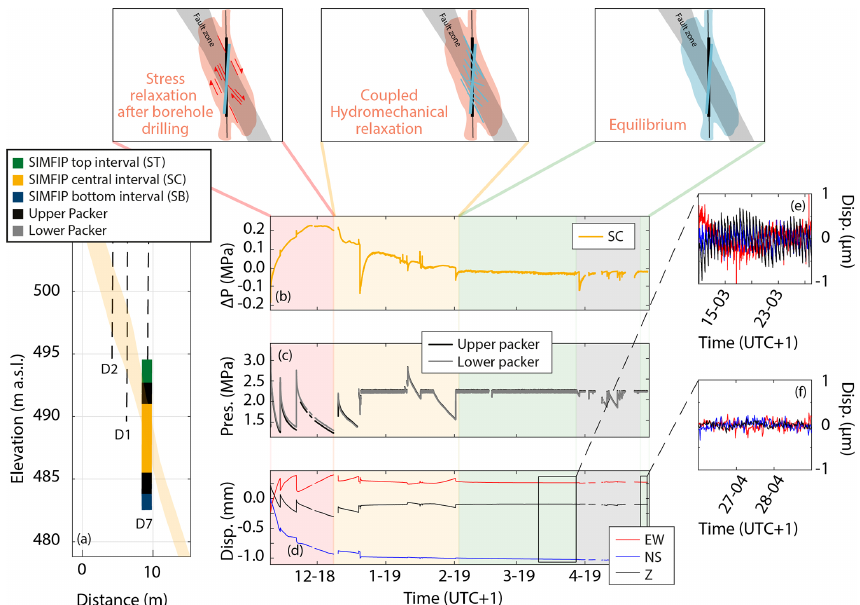
Figure 12. (a) Position of the SIMFIP probe across the fault zone in borehole BCS-D7. (b–d) Long-term fault zone displacement and pore pressure monitoring: (b) interval pressure, (c) packer pressure, (d) (EW, NS, Z) displacement of the upper packer of the SIMFIP probe (fault hanging wall). (e, f) Enlargement of relative and detrended displacement monitoring in stable periods before and after packer pressure calibration.